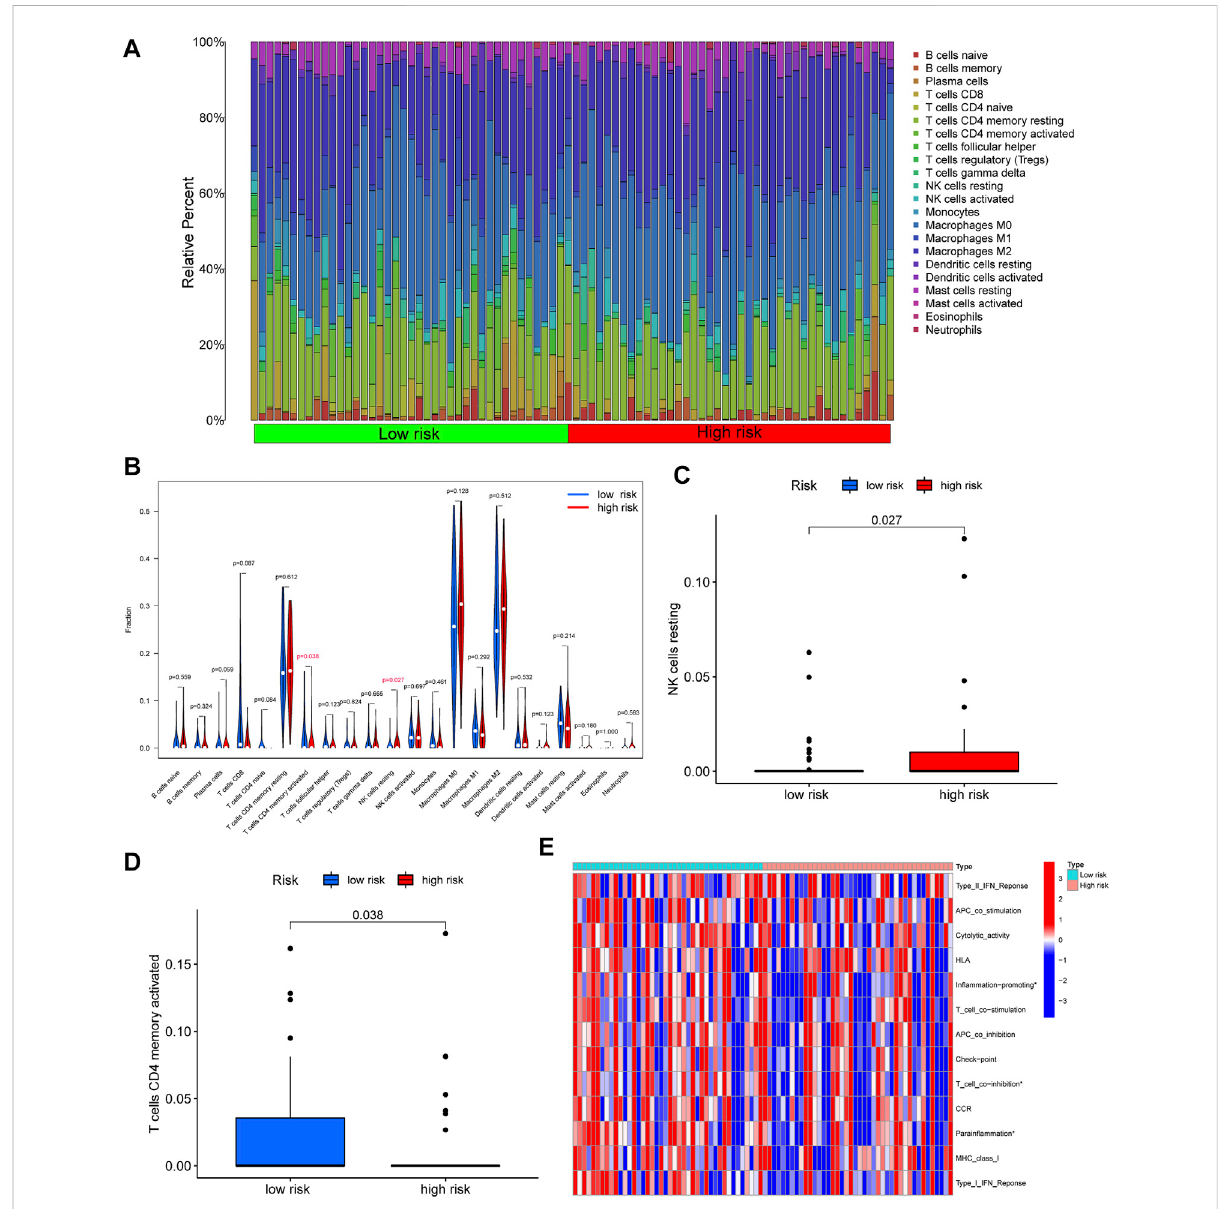
FIGURE 6 Correlation between immune and risk score model. (A) The 22 immune cells landscape between high- and low-risk groups. (B) Comparison with the percentage of immune cells in the high- and low-risk groups. (C – D) A signi fi cant percentage of T cells CD4 memory activated and NK cells resting. (E) The signi fi cant immune-related functions in the different risk score groups ( p p <